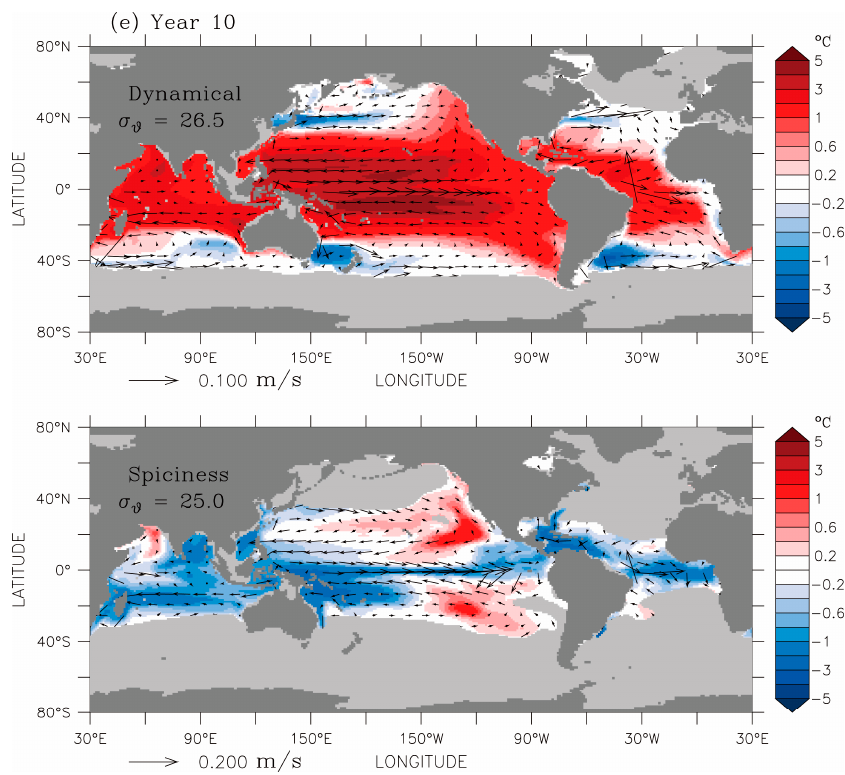
Figure 7. ( a ) Components of temperature anomaly δ T (°C) between CTL and W15 simulations after 1 year of OTEC activity (determined with the method of Furue et al. [33]): dynamical along CTL isopycnal σ θ = 26.5 kg m − 3 (upper panel); spiciness along CTL isopycnal σ θ = 25 kg m − 3 (lower panel). The light grey shading indicates regions where the density surfaces do not exist. Also shown are velocity vectors from CTL . ( b ) Same as Figure 7a after 3 years of OTEC activity. ( c ) Same as Figure 7a after 5 years of OTEC activity. ( d ) Same as Figure 7a after 7 years of OTEC activity. ( e ) Same as Figure 7a after 10 years of OTEC activity.